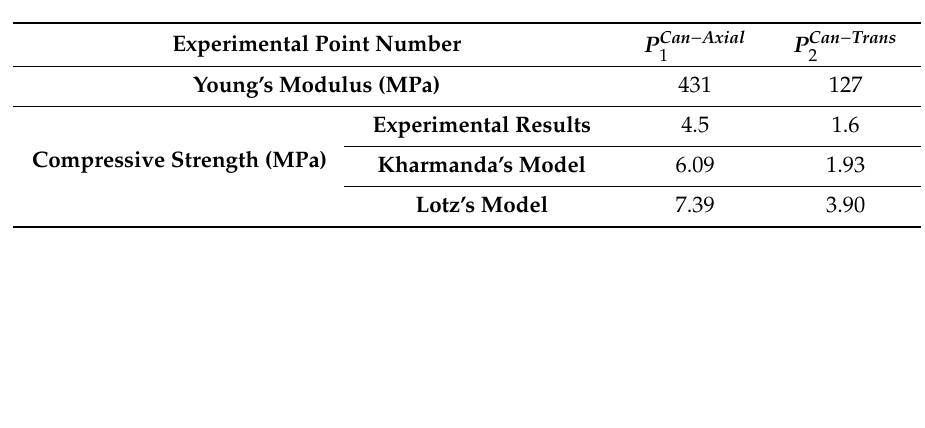
Figure 4. A comparison between experimental compressive stress for Lotz’s model (Equation (14)) and Kharmanda’s model (Equation (16)) for cancellous bone in the axial direction, and Lotz’s model (Equation (15)) and Kharmanda’s model (Equation (16)) for cancellous bone in the transversal direction. Table 4. A comparison of experimental compressive stress with Kharmanda’s and Lotz’s models for cancellous bone in axial and transversal